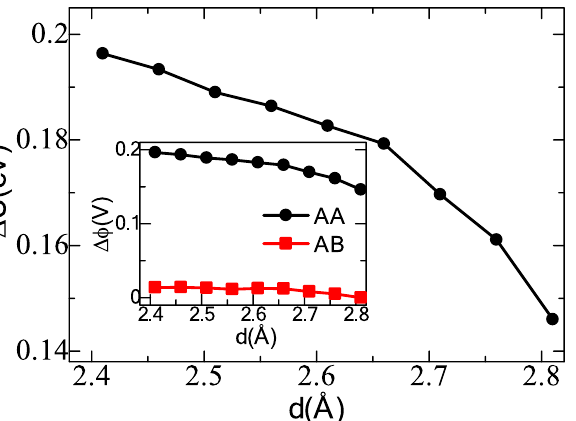
Figure 6. Variation of the electrostatic potential differences between the N-atoms of the top and bottom layers for AA stacking pattern. Inset shows the comparison of estimated electric voltages between A–B and A–A stacking patterns with compression of the interlayer distance of the InN bilayer from 2.81 to 2.41 Å.